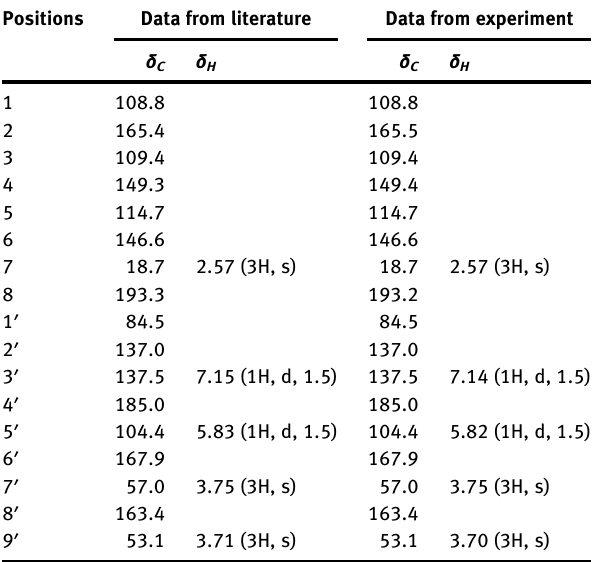
Table  : Comparison of experimental NMR data with the literature [  ] for geodin  . a